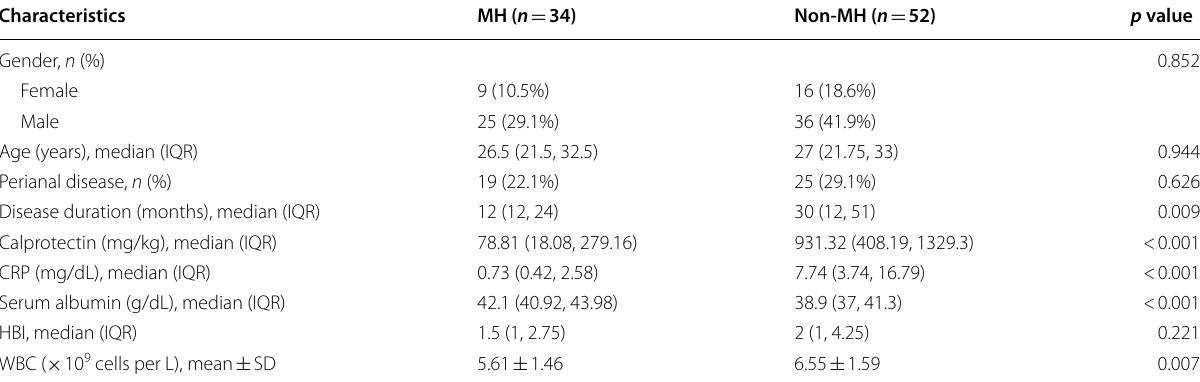
MH Mucosal healing, CRP C-reactive protein, HBI Harvey–Bradshaw index, WBC White blood cell, IQR Interquartile range, SD Standard deviation Table 2 Clinical characteristics of patients with or without TH